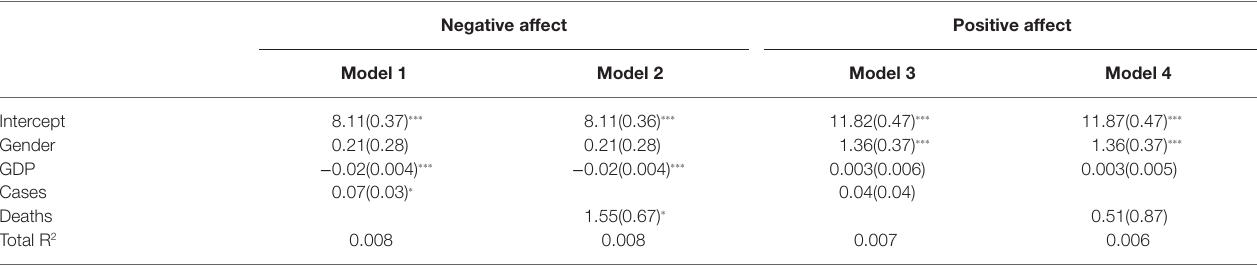
TABLE 2 | The main effect of pandemic severity on the well-being of working adults.